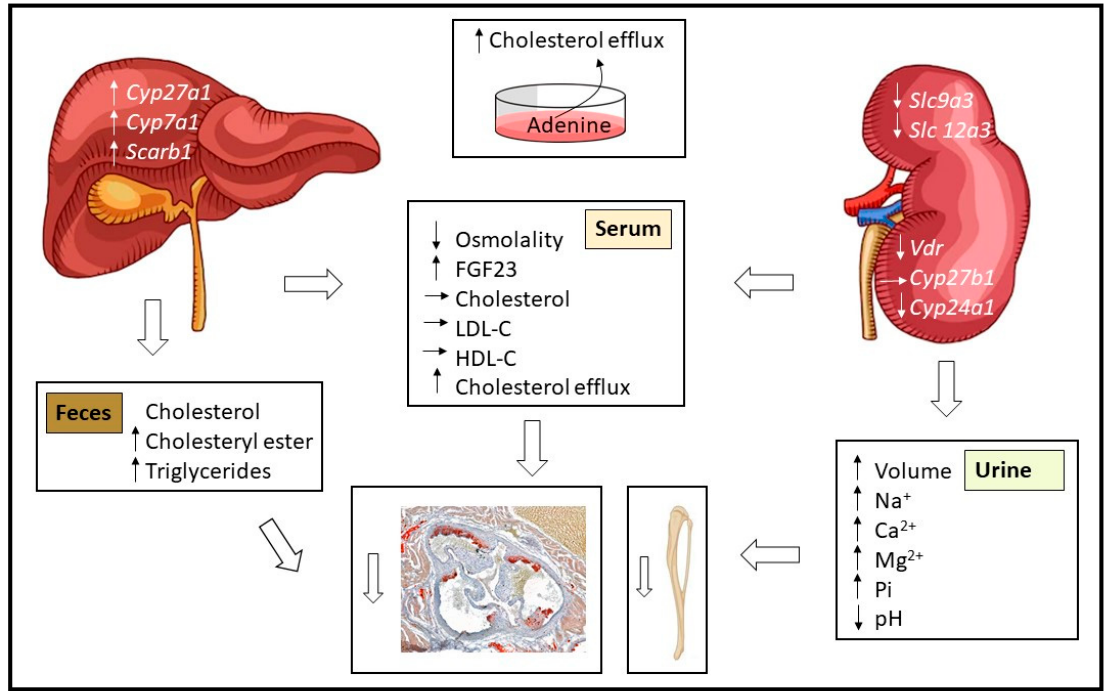
Figure 7. Possible mechanisms for the anti-atherosclerotic effect of adenine and consequences on bones in ApoE KO mice. Adenine induced tubular damage illustrated by increased FGF23 in serum and leading to changes in urinary excretion and composition. The kidney compensates by downregulating the transporters involved in Na + transport. The expression of the genes accounting for vitamin D metabolism is also downregulated. Due to urinary Ca 2+ and Pi loss, the growth of the tibia is slowed. Mice fed with adenine develop fewer atherosclerotic lesions. This phenotype is mainly driven by a serum more efficient to efflux cholesterol and by an increased fecal output. In the liver, genes involved in cholesterol efflux and homeostasis are upregulated. Adenine itself enhances cholesterol efflux in vitro.